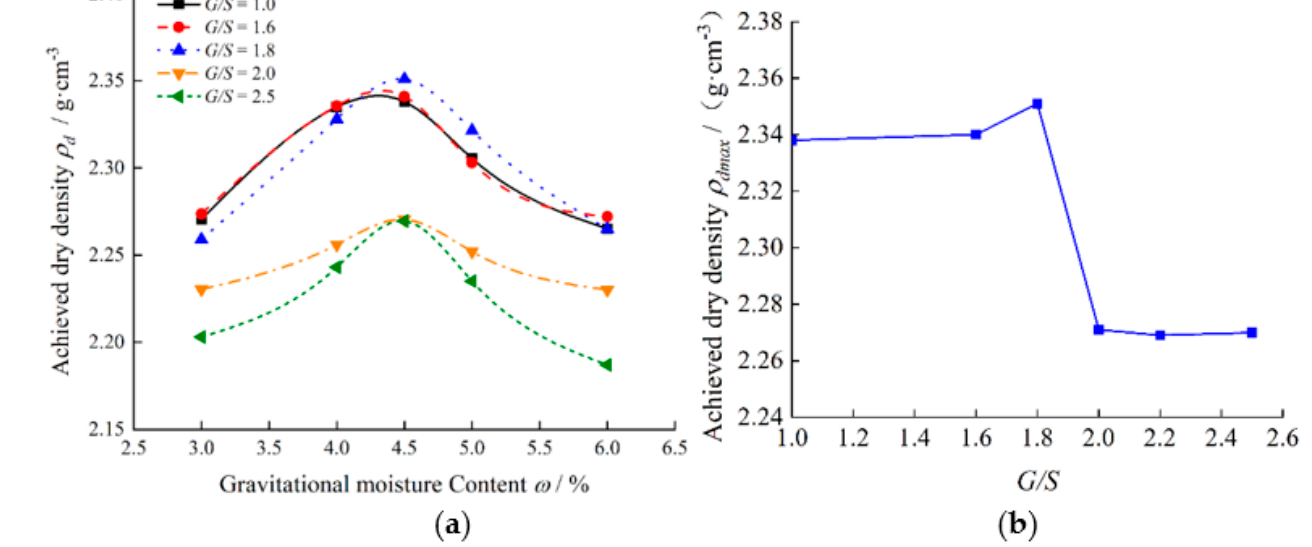
Figure 2. Laboratory compaction curves of unbound aggregate specimens: ( a ) achieved dry density versus moisture content and ( b ) achieved dry density versus G/S .